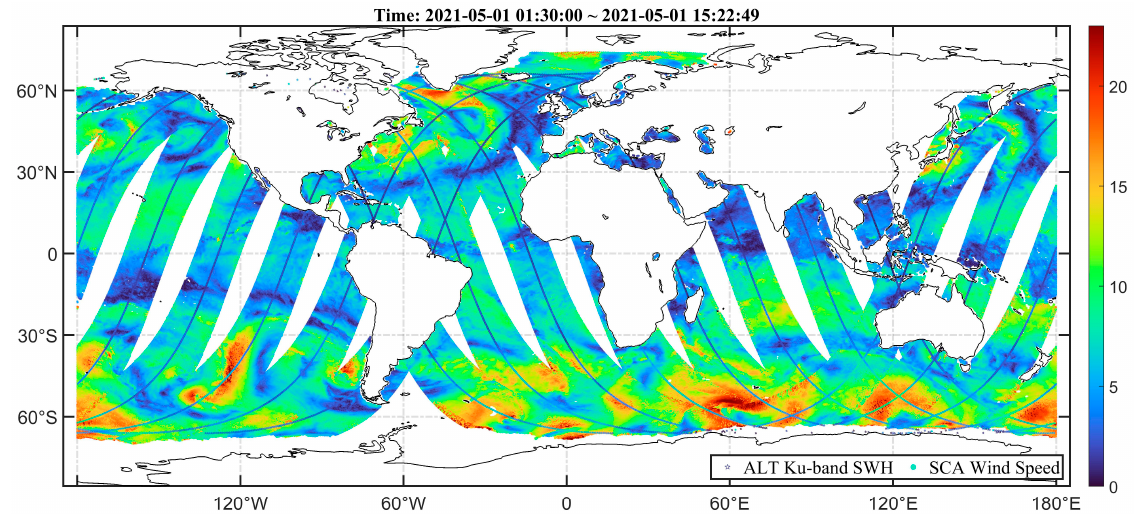
Figure 1. Wind speed information from SCA and the Ku-band SWH from ALT are obtained simultaneously from HY-2C on 1 May 2021.